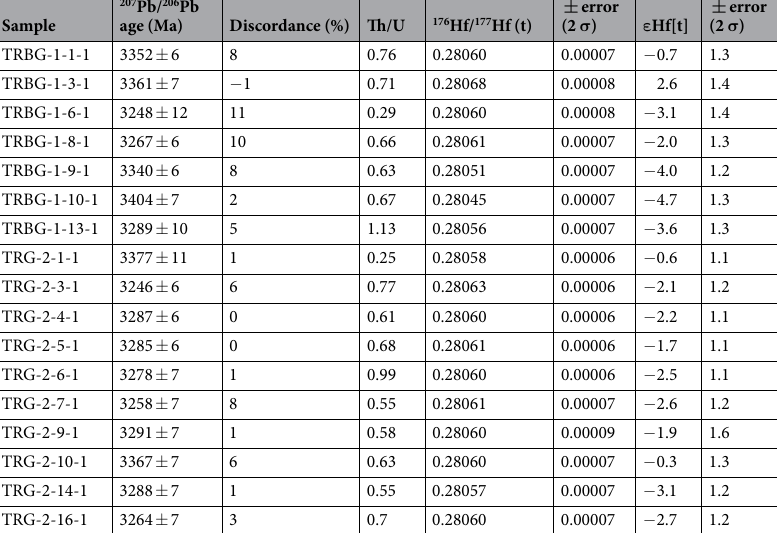
Table 2. Selected SHRIMP U-Pb and Lu-Hf isotopic data for samples TRBG-1 (SG-I) and TRG-2 (SG-III). * 207 Pb/ 206 Pb age data (Ma) with ≤ 10% discordance are presented (including 1 spot with > 10% discordance but